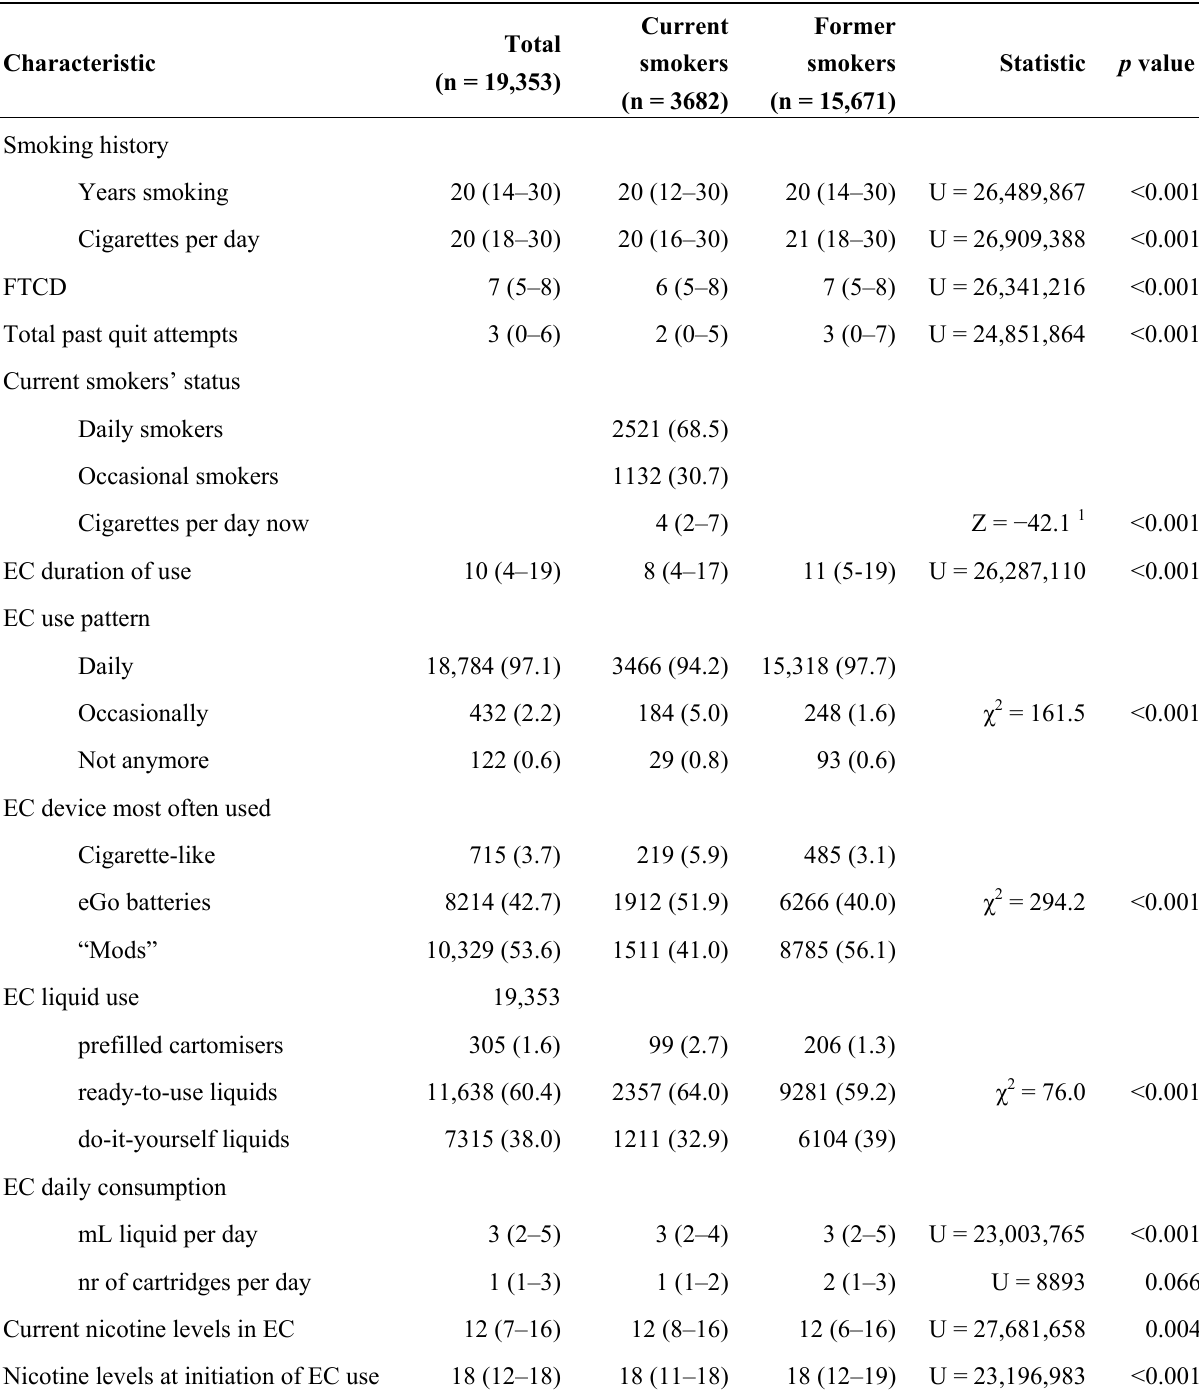
Table 2. Past and current smoking status and electronic cigarette use